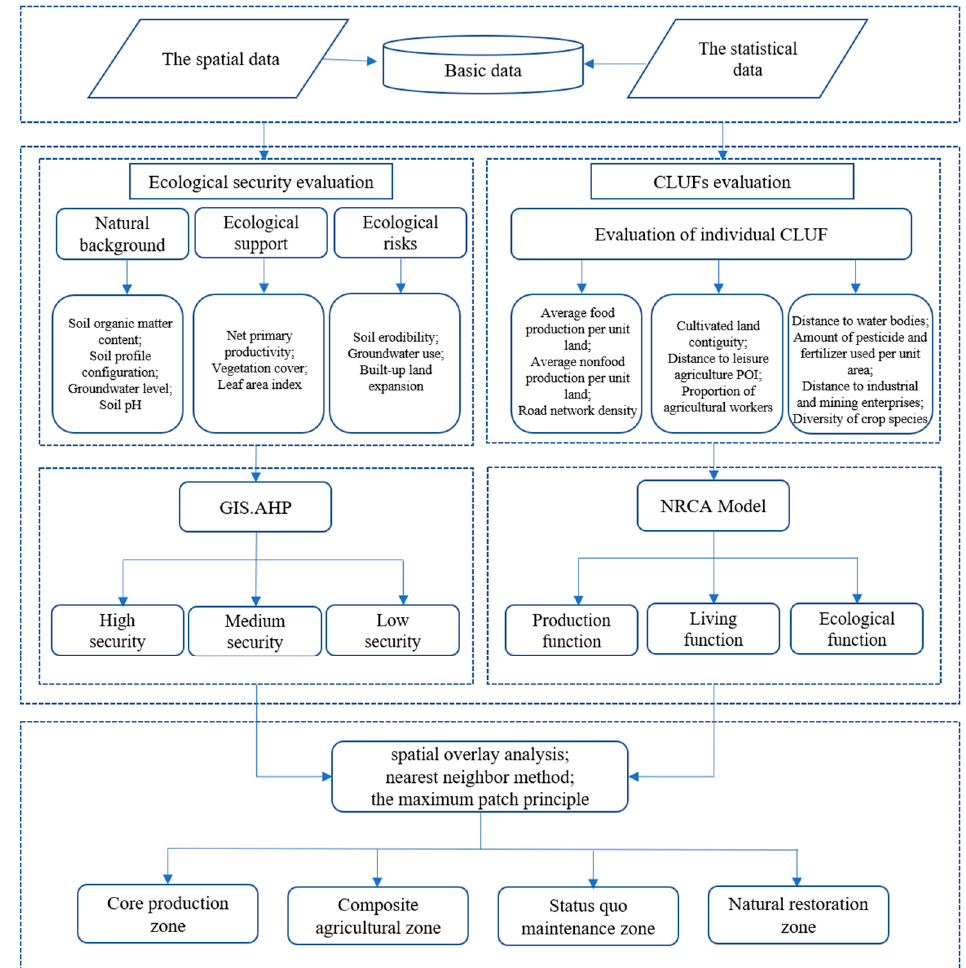
Figure 2. Research framework for optimizing cultivated land use.